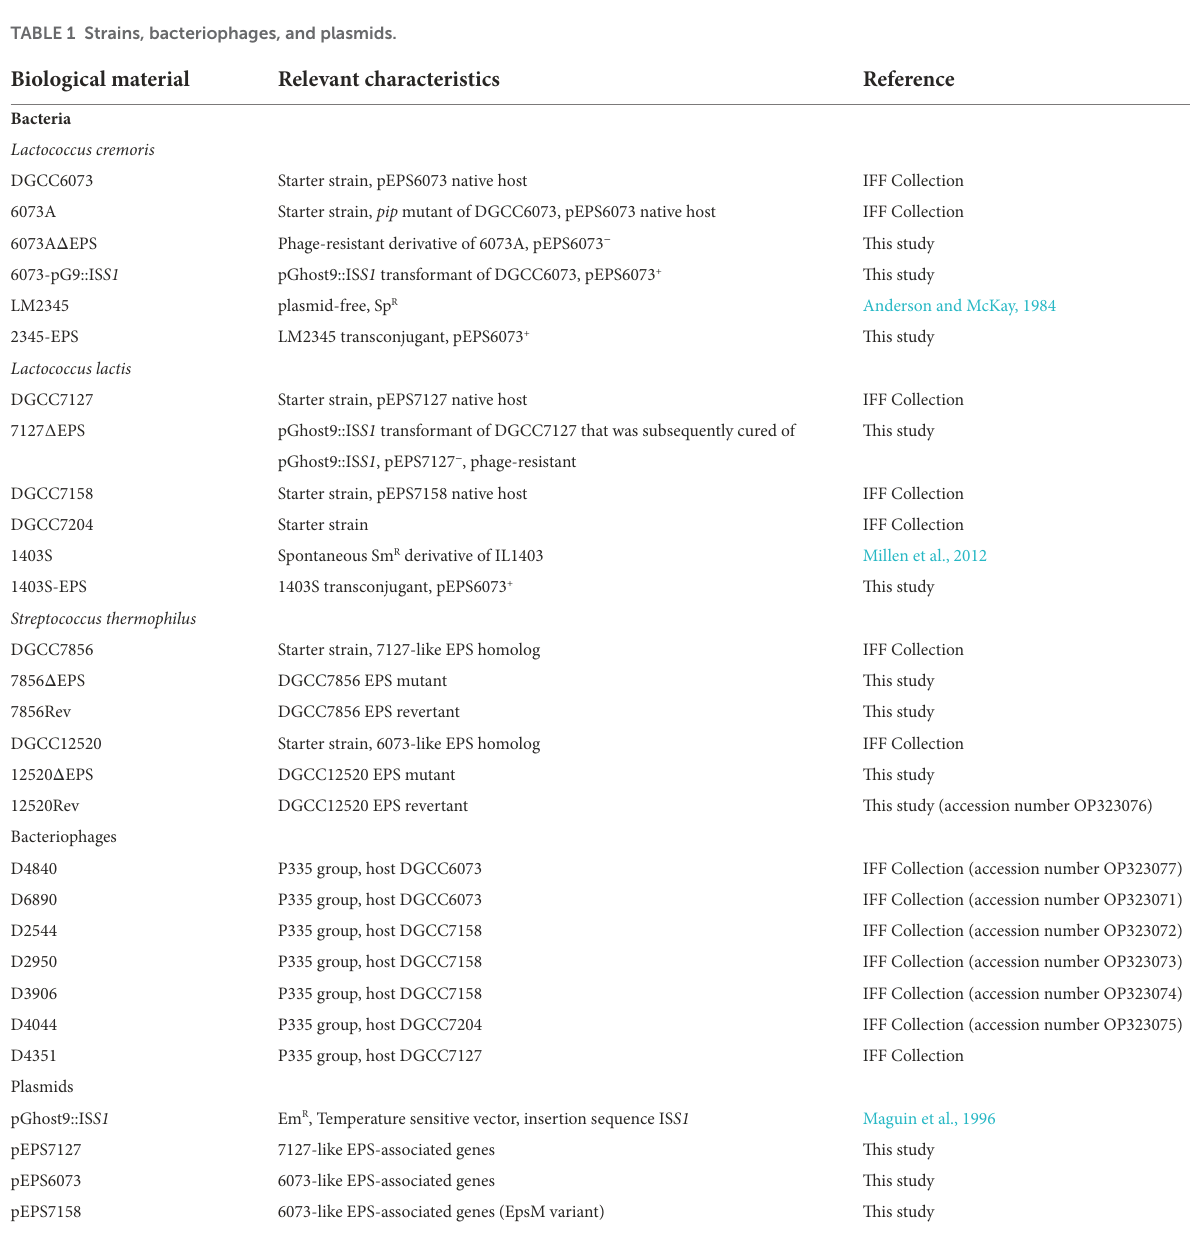
TABLE 1 Strains, bacteriophages, and plasmids. Biological material Relevant